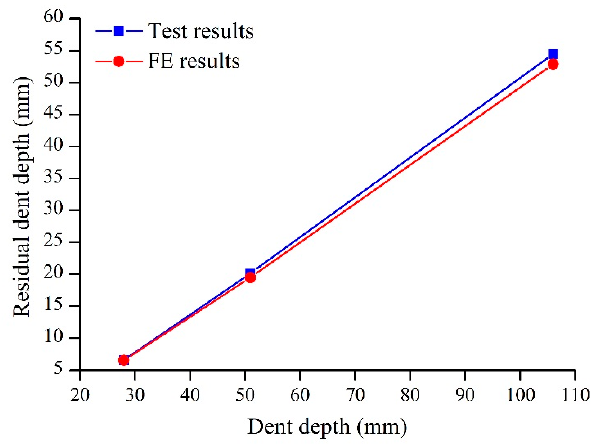
Figure 5. Comparison of test results [13] with finite element results.